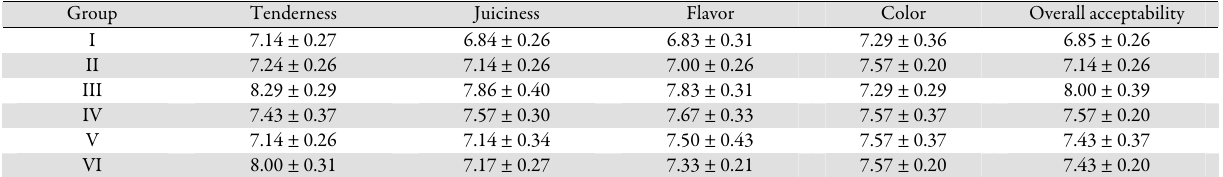
Table 3. Organoleptic characteristics of fresh meat in different groups of broiler chicks fed with neem leaf and/or spirulina substituted diet Group